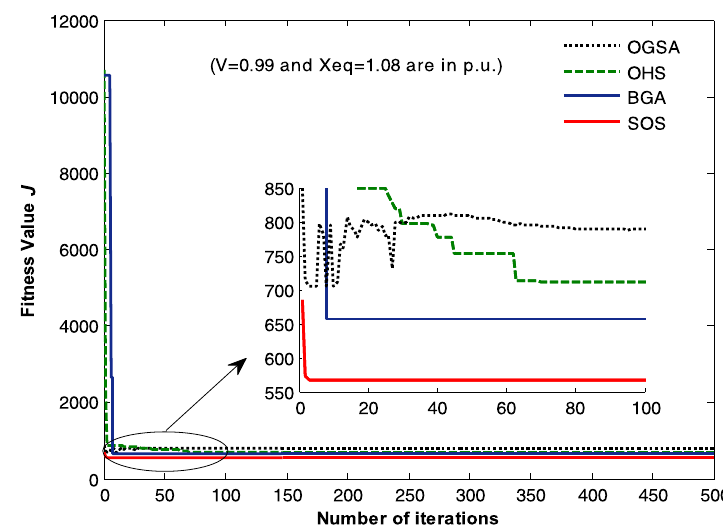
Fig. 10 Comparative convergence profile study among the algorithms